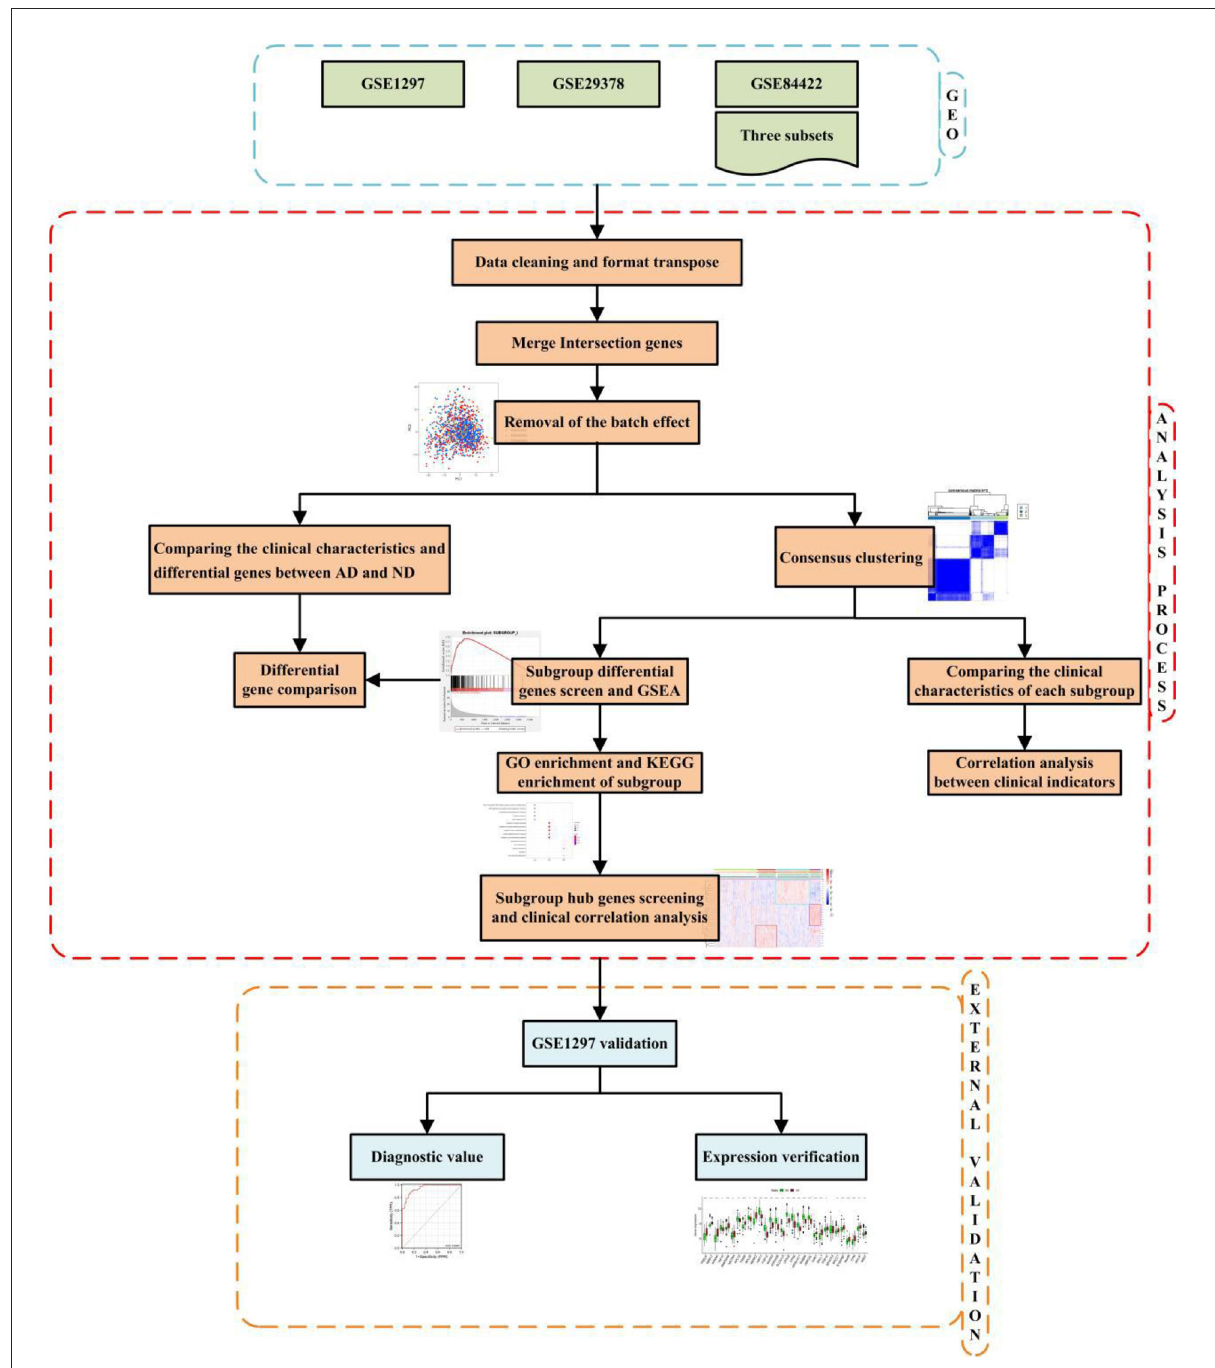
FIGURE1 Technical